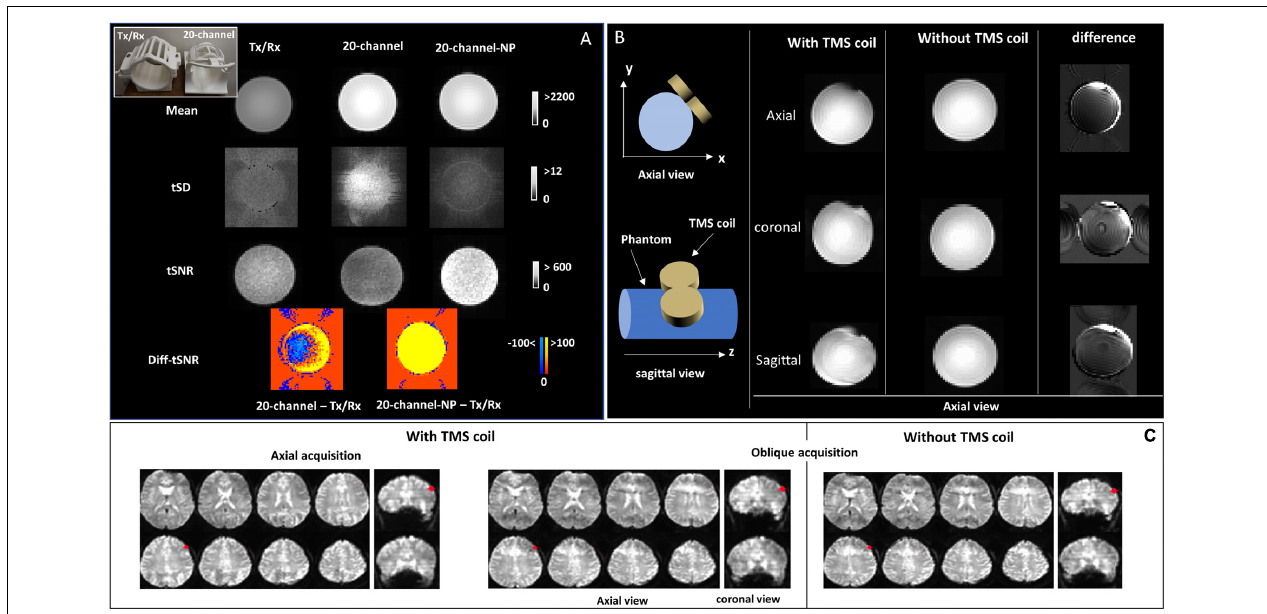
FIGURE 1 | (A) A picture of the Tx/Rx and 20-channel coils at the top-left corner. MRI signal intensity (mean), temporal standard deviation (tSD), and temporal signal-to-noise ratio (tSNR) images are shown for echo-planar imaging (EPI) images of the bottle phantom acquired with both rf coils (Tx/Rx and 20-channel); tSNR differences between 20-channel acquisitions (with and without parallel imaging) and Tx/Rx acquisitions (Diff-tSNR) are also shown; NP, no parallel imaging. (B) Schematic design of the transcranial magnetic stimulation (TMS) coil positioned over the left side of the phantom, oblique to the xy-plane. Axial view of the mean EPI images is displayed for the axial, sagittal, and coronal data acquisition of the bottle phantom with and without the TMS coil. The difference images (without - with TMS coil) are also displayed. (C) Brain EPI images for the axial and oblique data acquisition acquired with the TMS coil, positioned over the left dorsolateral prefrontal cortex (DLPFC, MNI = -50,30,36, highlighted in red), in addition to the oblique acquisition without the TMS coil are shown, on coronal and axial